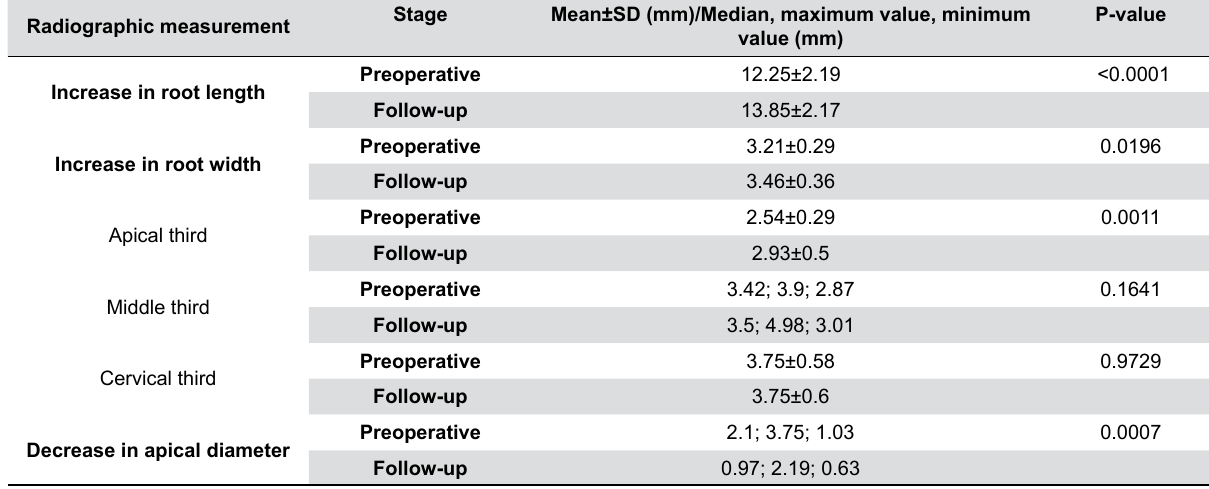
T-test was used for values expressed as mean±SD; Wilcoxon test was used for values expressed as median, maximum value, and minimum value.